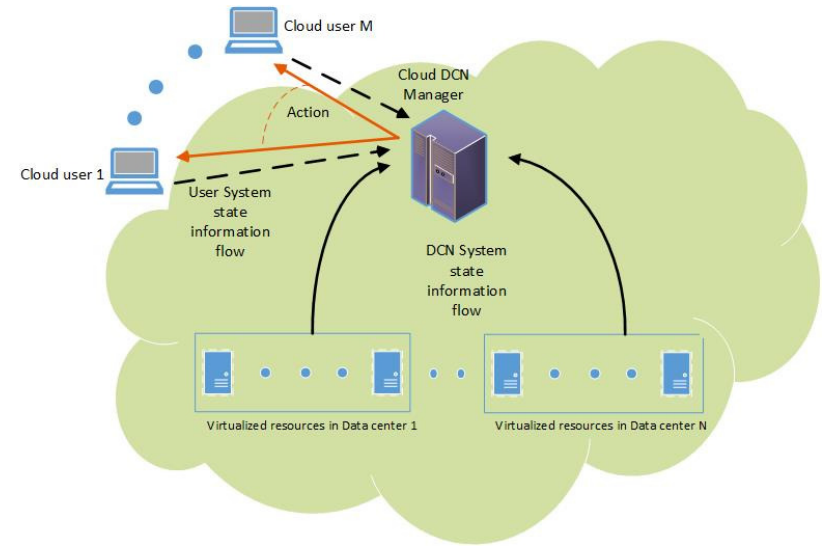
Figure 4. Mapping the elements of the proposed Q-learning algorithm to the